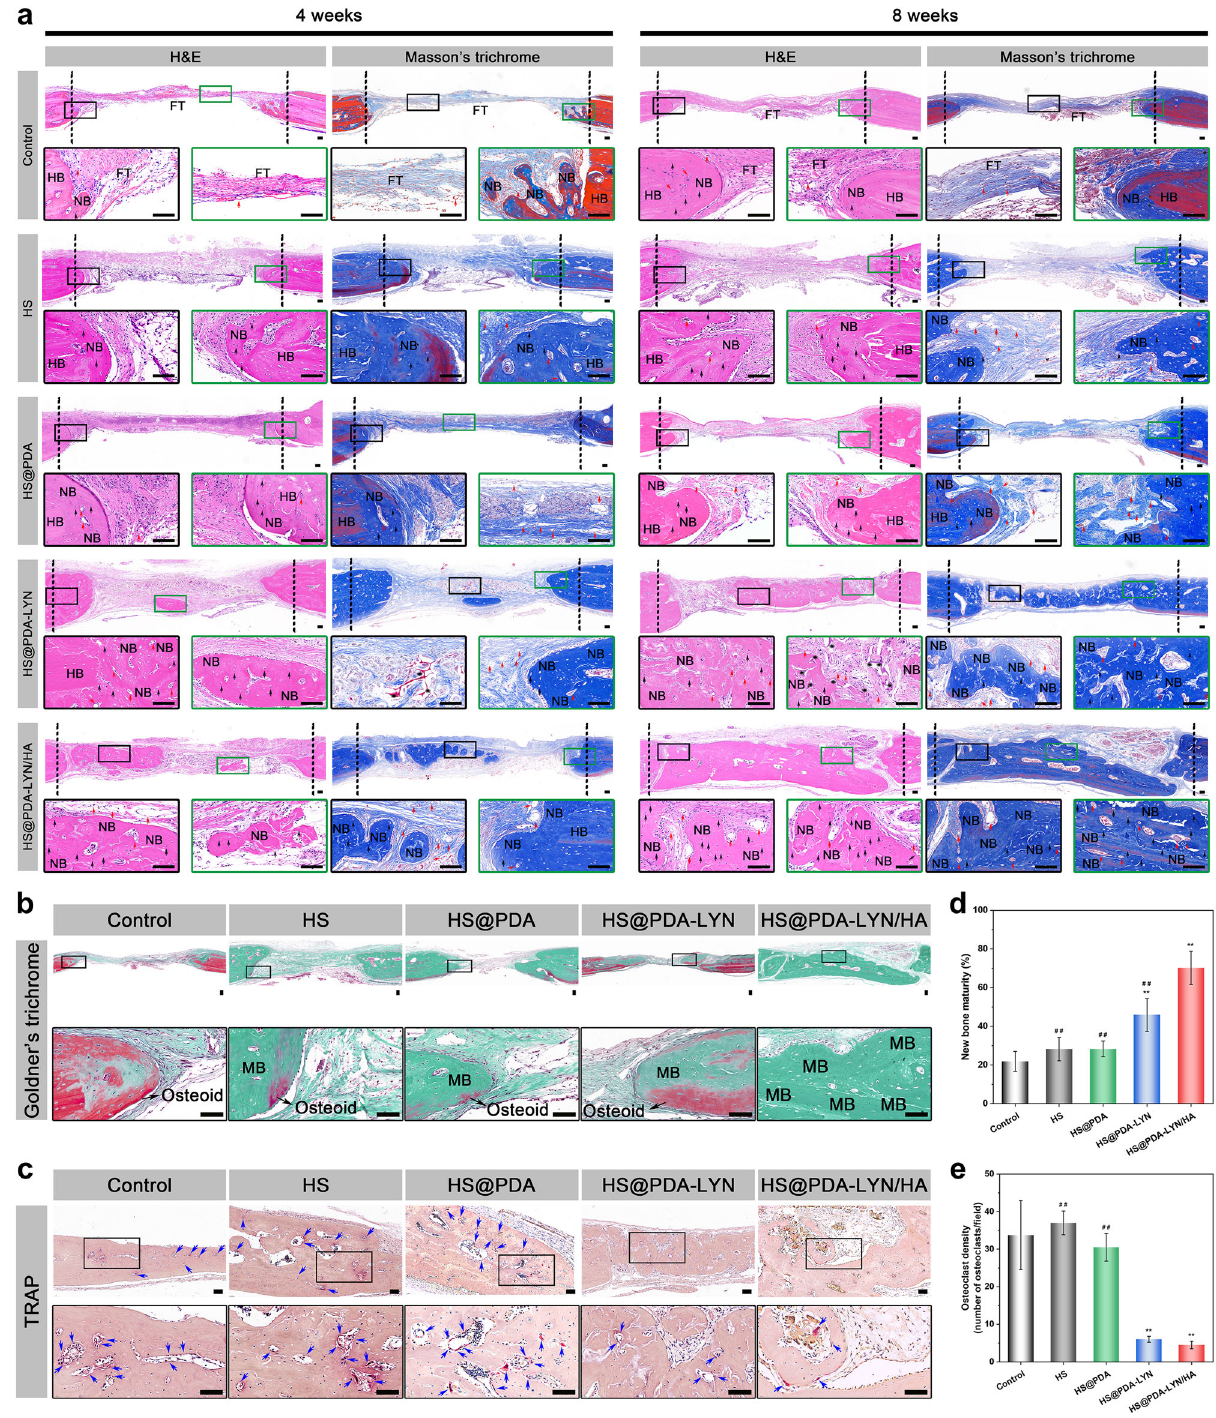
Fig. 9 Histomorphological examination of the bone defect region after different treatments. a Representative H&E staining and Masson ’ s trichrome staining of the calvarial defect area at 4 and 8 weeks after implantation. Representative b Goldner ’ s trichrome staining and c TRAP staining of the calvarial defect area at 8 weeks postimplantation. Black arrows = osteoblasts; red arrows = blood vessels; blue arrows = osteoclasts; black asterisks: residual material; HB = host bone; NB = newly formed bone; FT = fi brous tissue; MB = mature/mineralized bone. Black dotted lines indicate the boundary of the rat calvarial defect. Quantitative analysis of d the percentage of newly formed mature bone area and e the number of osteoclasts in the regenerated tissues. Scale bar in a , b : 100 μ m. Data are expressed as the mean ± SD ( n = 4). * P < 0.05 and ** P < 0.01 indicate signi fi cant differences compared with the control group. # P < 0.05 and # # P < 0.01 indicate signi fi cant differences compared with the HS@PDA-LYN/HA